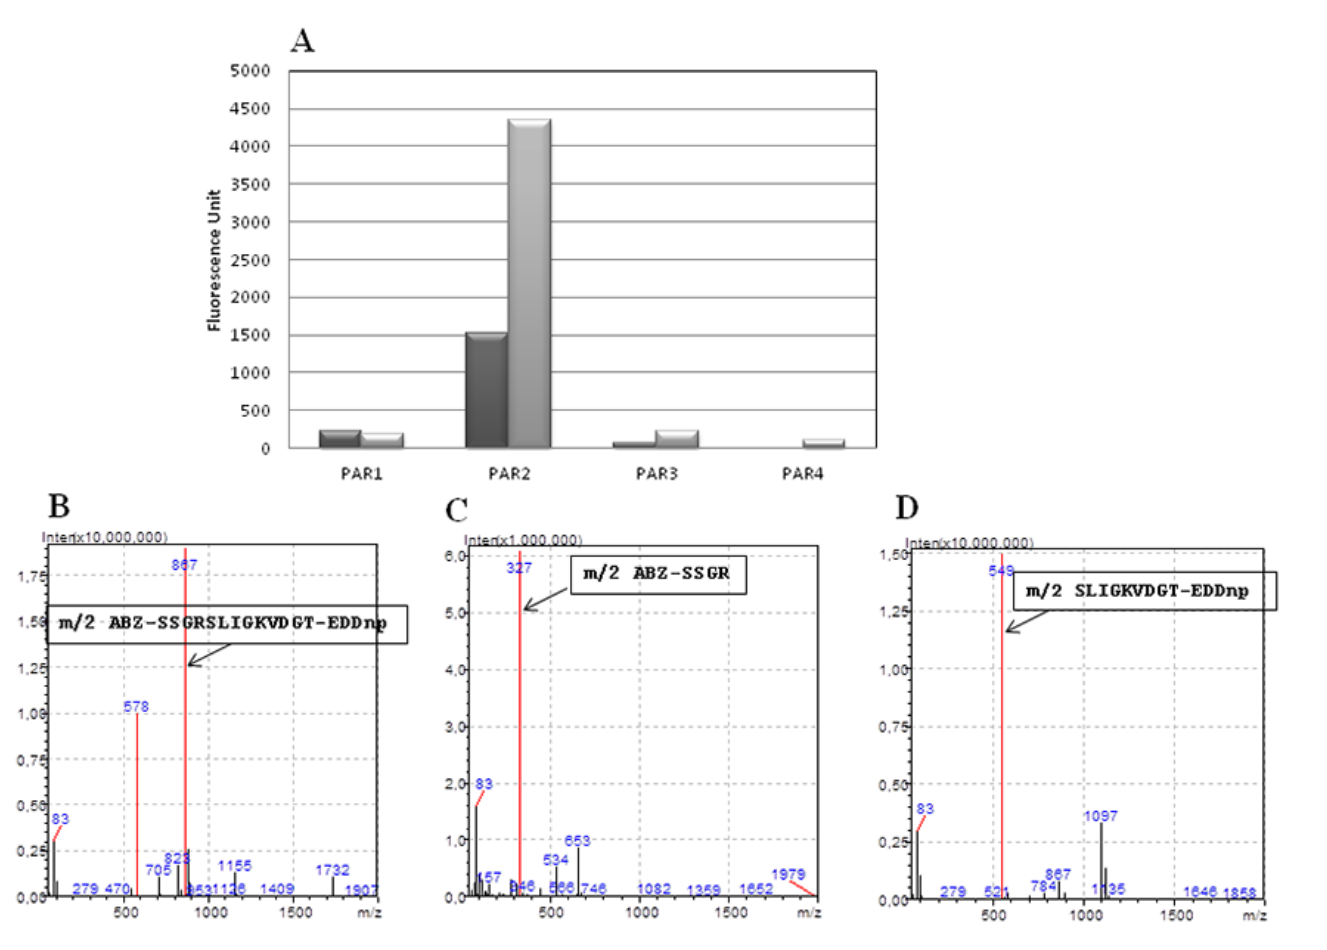
Figure 3. Hydrolysis of Abz-PAR-EDDnp (Abz-protease-activated receptor EDDnp) peptides by purified triapsin. (A) Peptide sequences for human PAR-1, -2, -3, and -4 activation: PAR-1_TLDPR↓SFLLRN, PAR-2_SSKGR↓SLIGKVDGT, PAR-3_TLPIK↓TFRGAPPNS, PAR-4_ LPAPR↓GYPGQVCAN were incubated with triapsin purified on Superdex G 75. Assays were performed with triapsin purified on Superdex G75 and 125 μM each peptide in 100 mM Tris-HCl buffer pH 8.0 at 37°C in a Microplate Spectrophotometer (Gene5_BioTek® Instruments) and read at 320 nm and 420 nm for excitation and emission, respectively. (B) Molecular ion at m/z 867 corresponds to m/2 of the whole peptide (Abz-SSKGRSLIGKVDGT-EDDnp). (C) Molecular ion at m/z 327.0 corresponds to m/2 of the fragment Abz-SSKGR from PAR-2 incubated with triapsin. (D) Molecular ion at m/z 549 corresponds to m/2 of the fragment SLIGKVDGT-EDDnp from PAR-2 incubated with